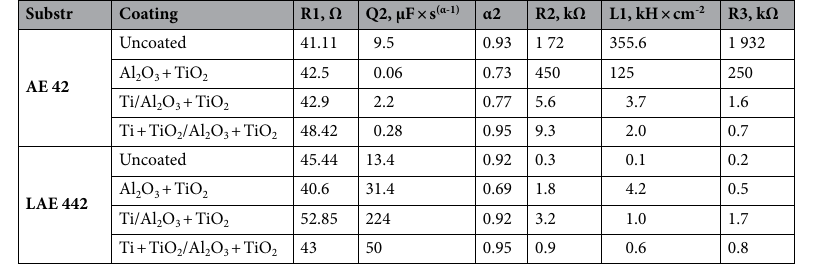
Table 4. Electrochemical impedance spectroscopy parameters.